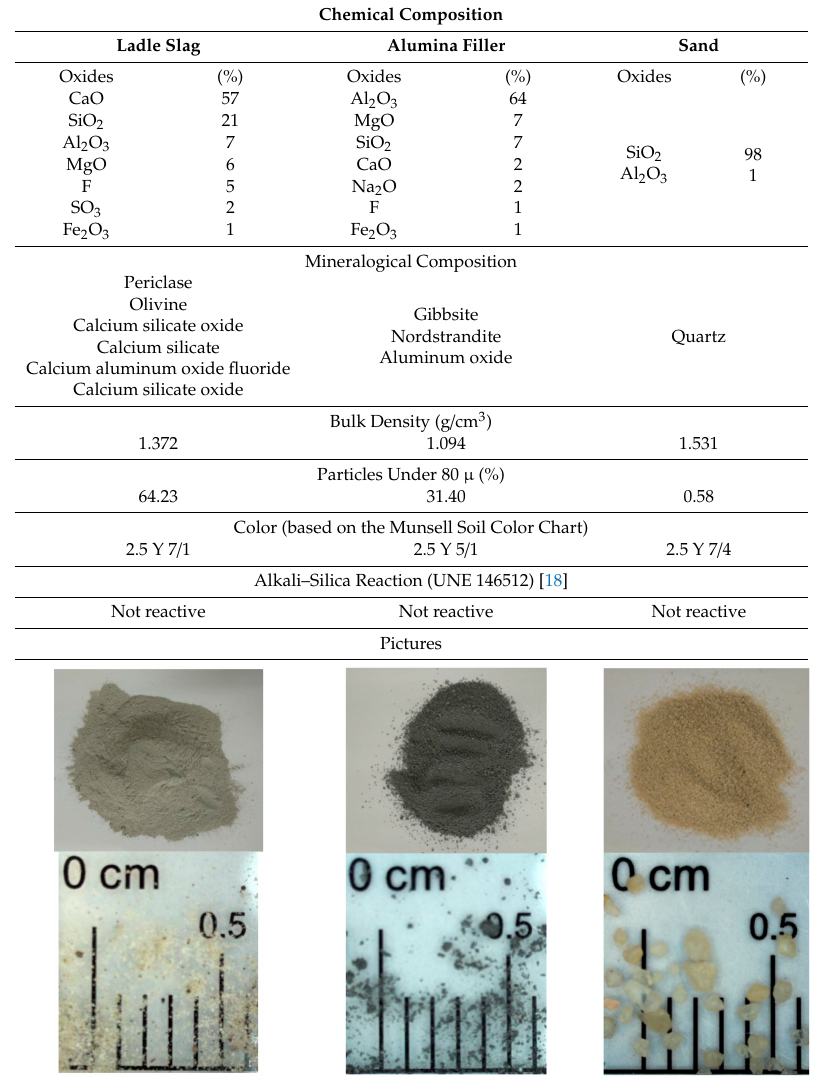
Figure 1. Granulometric curves of the target materials. Table 2. Chemical, mineralogical, and physical characterization of the target